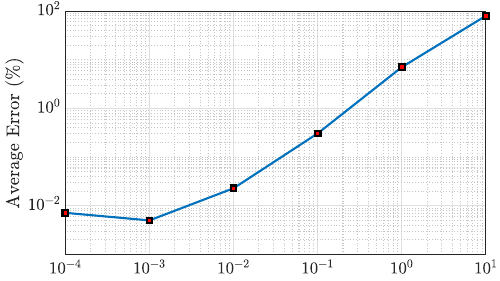
Figure 4. Determining the tuned λ in the CS optimization for simply supported beam.